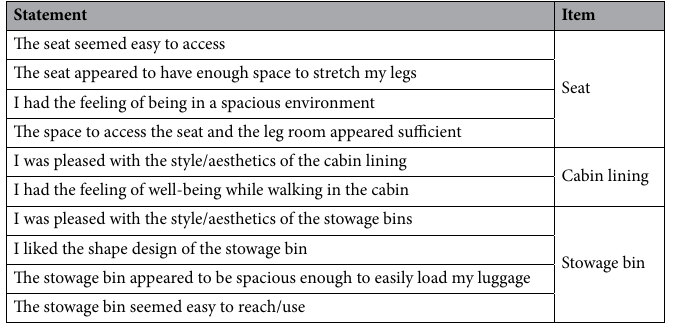
Table 3. Cabin scenario